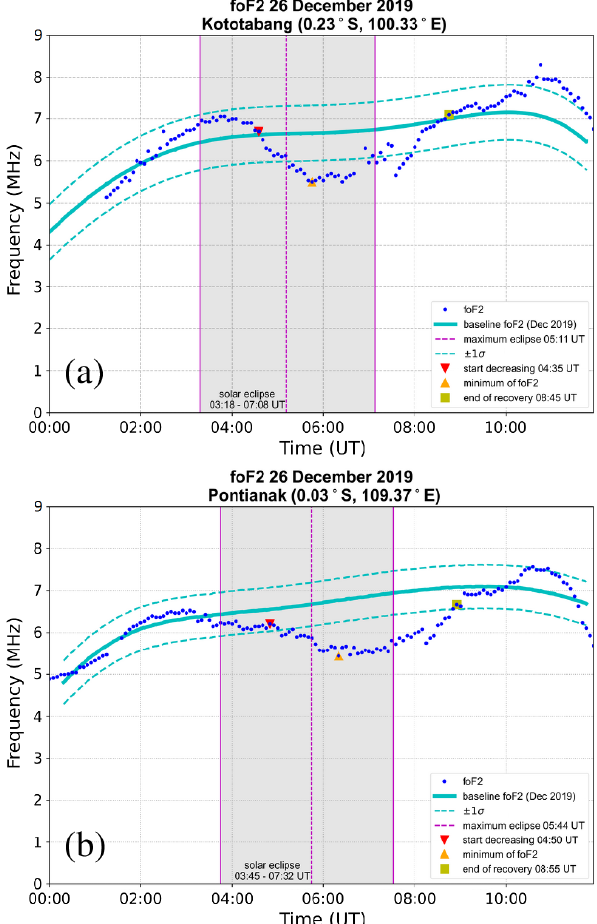
Figure 5. Time series plots of ionospheric F2-layer critical frequen- cies ( fo F2) from scaling of ionosonde measurements at (a) Kotota- bang and (b) Pontianak on 26 December 2019. Observation data are shown in blue, the baseline fo F2 level based on December 2019 averages is shown as cyan curves, and the solar eclipse period is indicated with gray